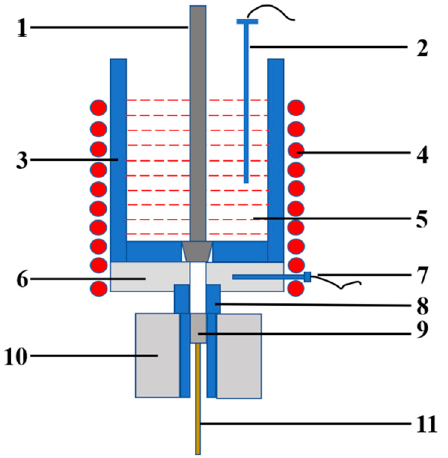
Figure 1. Principle schematic of the HCCM continuous casting technology: 1—graphite stopper, 2, 7—thermocouples, 3—graphite crucible, 4—temperature measuring device, 5—alloy solution, 6—graphite thermal type, 8—graphite mold, 9—dummy bar head, 10—crystallizer, 11—tow bar.